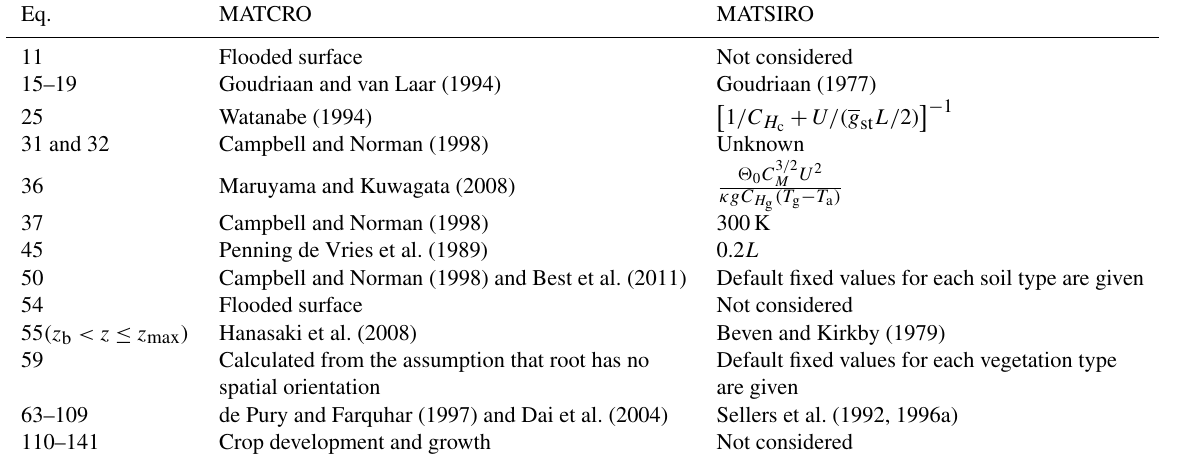
Table 3. Modifications from the original model,